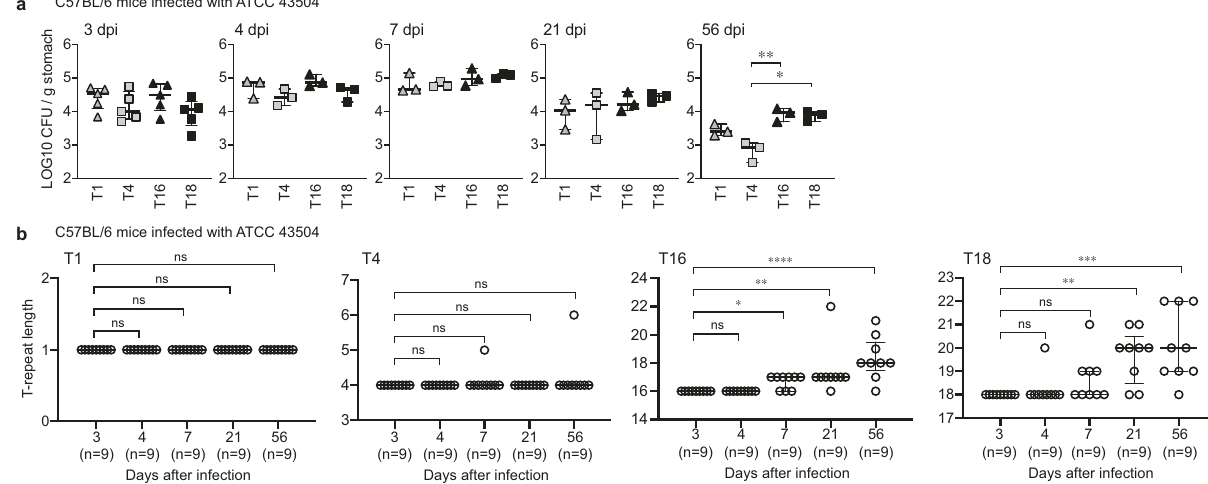
Fig. 5 Time-dependent changes in bacterial-host adaptation and the T-repeat length. a , b Time-dependent changes in the bacterial load in the infected mouse stomach ( a ) and length of the T-repeat region ( b ) in T1, T4, T16 and T18 strains recovered from mice. Data are presented as the median with interquartile range. Statistical signi fi cance determined by uncollected Dunn ’ s multiple comparison test (two-sided). * P = 0.0174, ** P = 0.0066 ( a ); * P = 0.0294, ** P = 0.0014, **** P < 0.0001 ( b , T16); ** P = 0.0012, *** P = 0.0002 ( b , T18); ns, not signi fi cant. Source data are provided as a Source Data fi le.